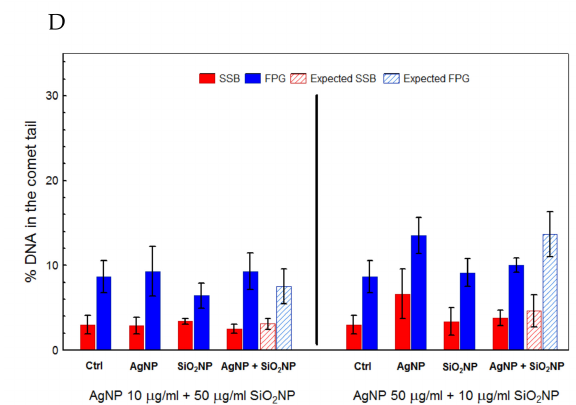
Figure4. Inductionofsingle-strandbreaks(SSB)andbasedamagerecognizedbyformamido-pyrimidine glycosylase (FPG) in HepG2 cells treated with the combination of AgNPs with AuNPs ( A ), CdTeQDs ( B ), TiO 2 NPs ( C ), and SiO 2 NPs (D ) for 2 h. Mean ± SD, n = 3. * denotes a statistically significant di ff erence from the unexposed control, P < 0.05. # denotes a statistically significant di ff erence between observed and expected values, P <